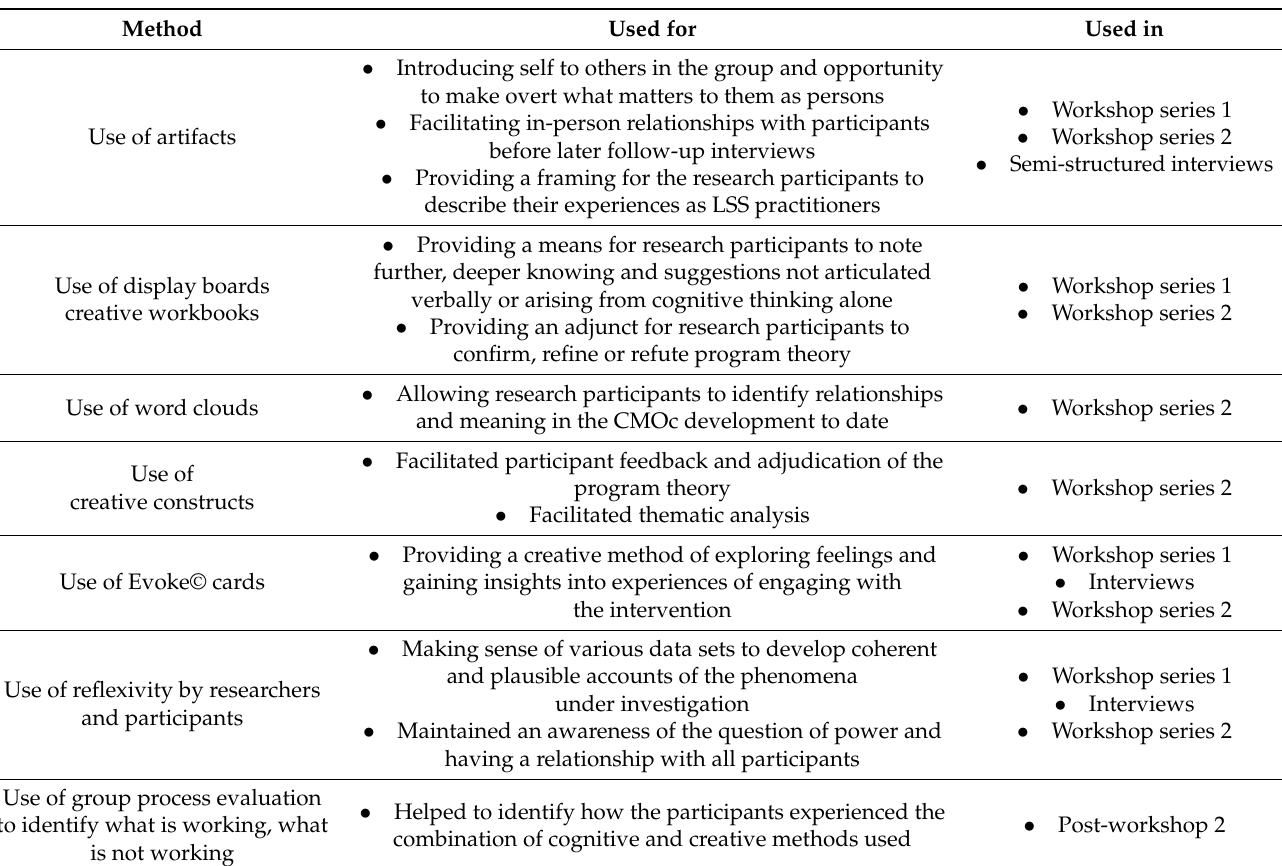
Table 1. Use of creative methods within our